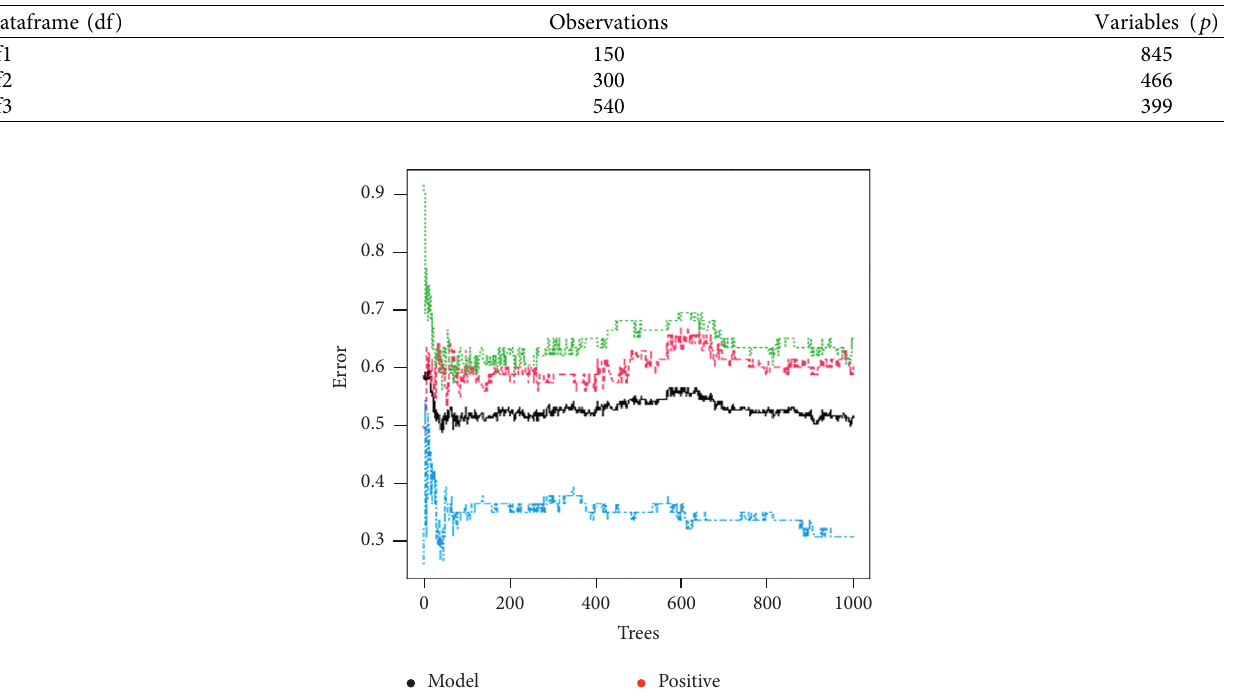
Table 1: Dimensions of datasets.